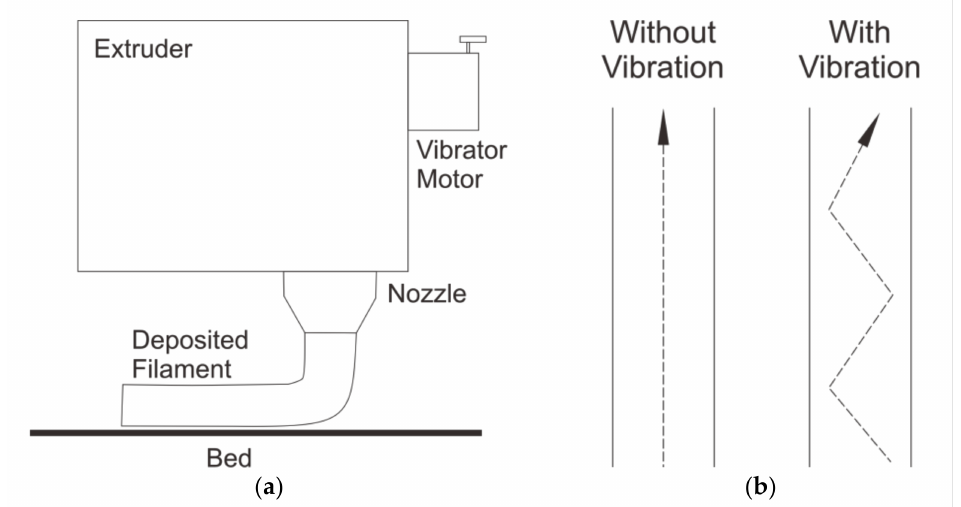
Figure 11. ( a ) A schematic illustration of the application of a vibrator at the extrusion head of an FFF 3D printer, ( b ) material deposition path with or without the application of